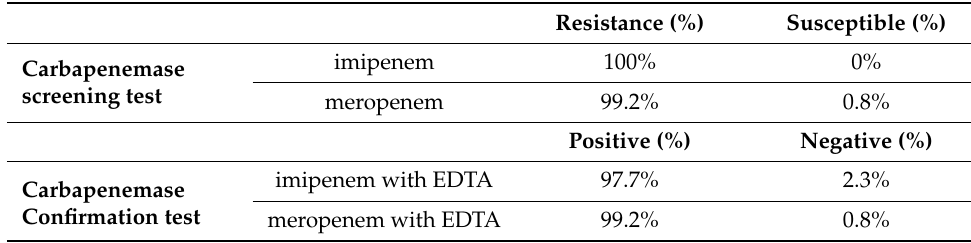
Table 5. Phenotypic test for detection of carbapenemase-producing A. baumannii . Carbapenemase screening test was performed with disk diffusion test while carbapenemase confirmation test was performed by Double-Disk Potentiation test.